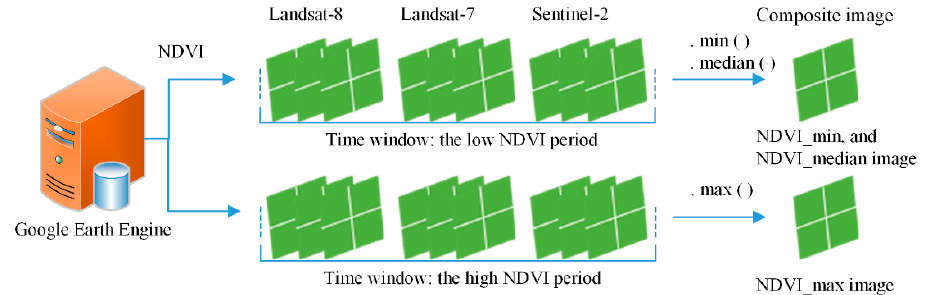
Figure 3. Sketch map for compositing Landsat-7 and -8 and Sentinel-2 imagery into a new composite image at a pixel-based scale using GEE. “.min()”, “.max()”, and “.median()” are algorithms from the Google Earth Engine (GEE). “NDVIs.min()” returns the minimal value of the normalized difference vegetation index (NDVI). “NDVIs.max()” returns the maximal value of the NDVI. “NDVIs.median()” returns the median value of the NDVI.